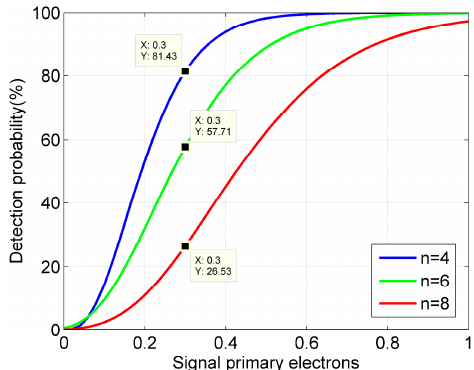
= 20, t = 50 ns, ψ Mcps ψ = ). Figure 5. Influence of threshold on detection probability ( N n = 1 Mcps d n